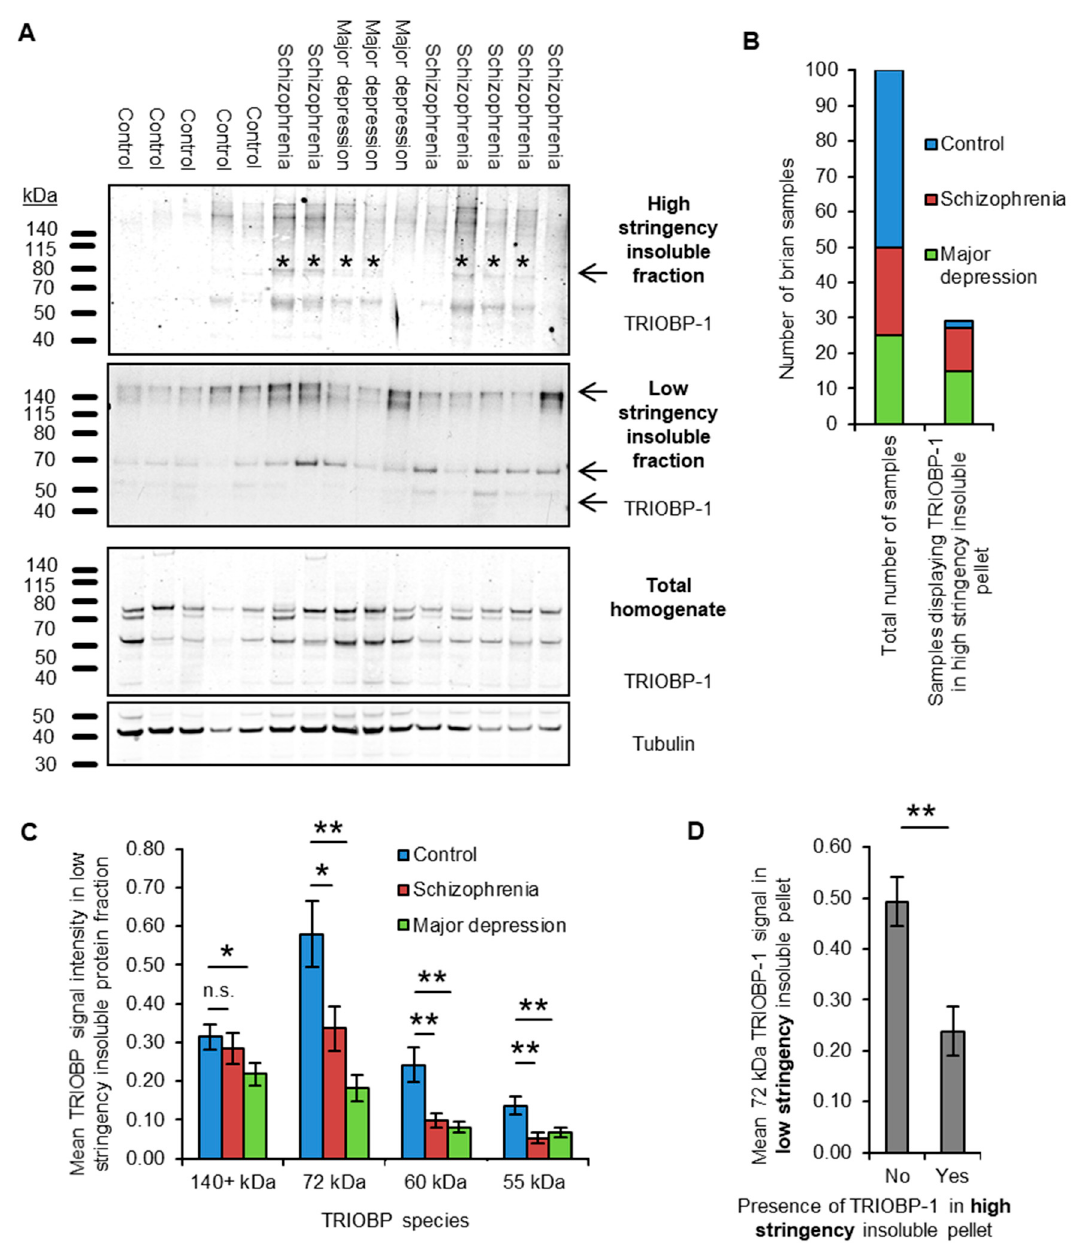
Figure 2. ( A ) Sample Western blot insoluble protein fractions of brain samples, derived using the high and low stringency purification protocols. Total homogenate is also shown. 15 of 100 samples in total are displayed. The protein species taken forward for further analysis are indicated by arrows. For the aggregated protein fraction, samples which were rated (in blinded analysis) as containing a TRIOBP-1 72 kDa species are indicated by an asterisk. Note that, for the sake of maximum clarity, different antibody concentrations and exposure settings were used for the blot of each fraction. ( B ) Bar graph showing the distribution of control, schizophrenia and major depression in both the complete set of 100 samples, and in the 29 which were rated as having TRIOBP-1 (72 kDa signal) in the high stringency insoluble fraction, demonstrating a significant enrichment in both mental illness groups. ( C ) Quantification of the mean signal strength in the low stringency insoluble protein fraction, for each of the four examined TRIOBP-1 species. Signal strength was normalized to the mean total TRIOBP-1 signal across all samples. ( D ) Comparison of the total level of 72 kDa TRIOBP-1 in low stringency insoluble protein fractions, between brain samples that either did or did not contain 72 kDa TRIOBP-1 in their high stringency insoluble fraction. * p < 0.05, ** p < 0.01, n.s.: not